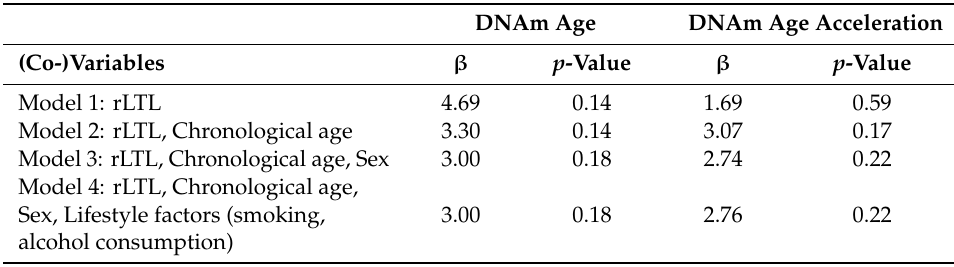
Table 3. Results of the linear regression of DNA methylation (DNAm) age and DNAm age acceleration on rLTL ( n =